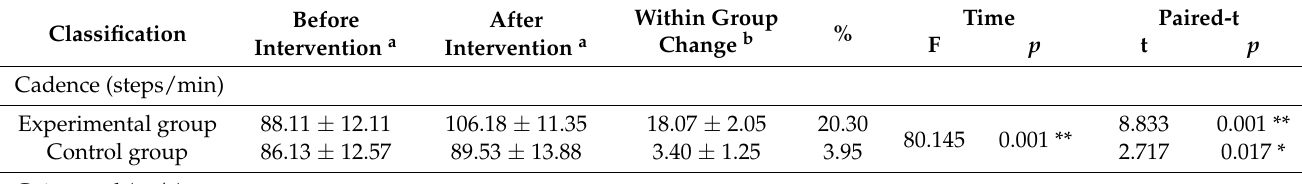
Table 3. Changes in gait performance before and after intervention on two intervention